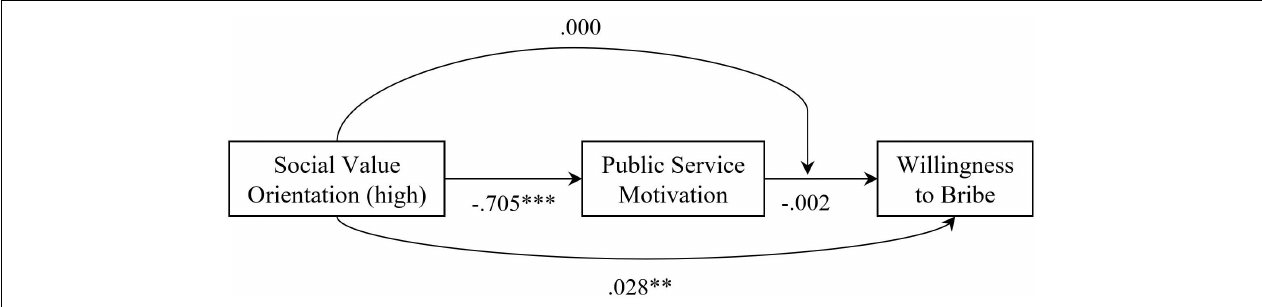
FIGURE 2 | Results of SEM analyses. Results of structural equation modeling, describing direct and indirect paths; based on pooled data by N = 622 respondents ( n = 1,242 observations); ∗∗ p < 0.01, ∗∗∗ p < 0.001.